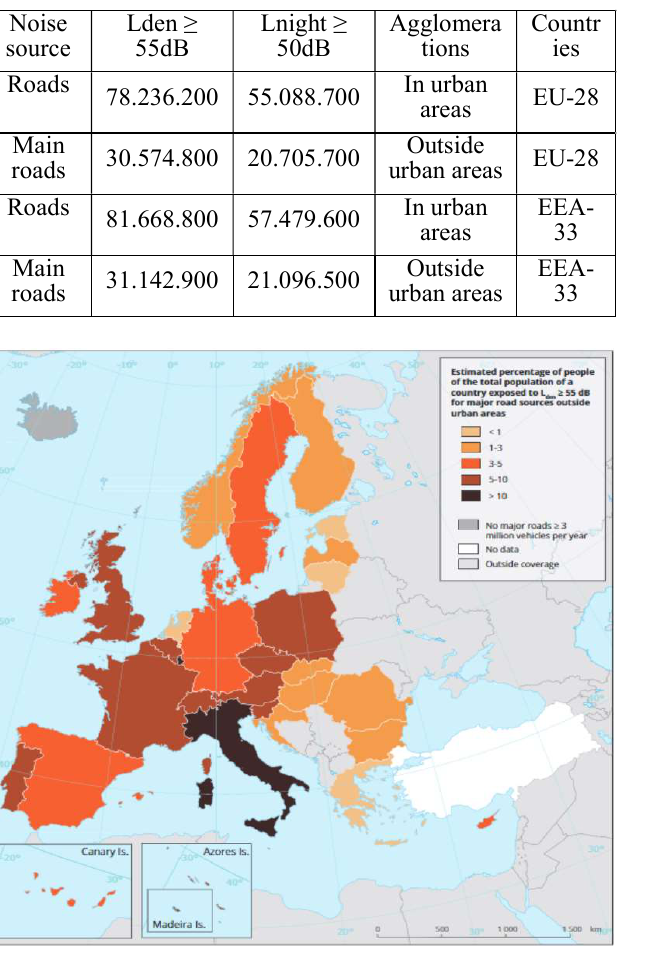
Table 2. Number of people exposed to average noise level during the night (Lden) ≥ 50 dB in Europe